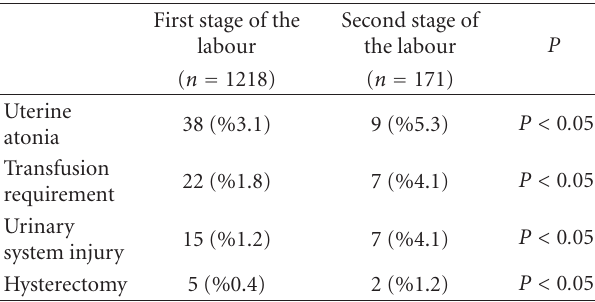
Table 2: Intraoperative findings and complications of cesarean sections in the first and second stages of the